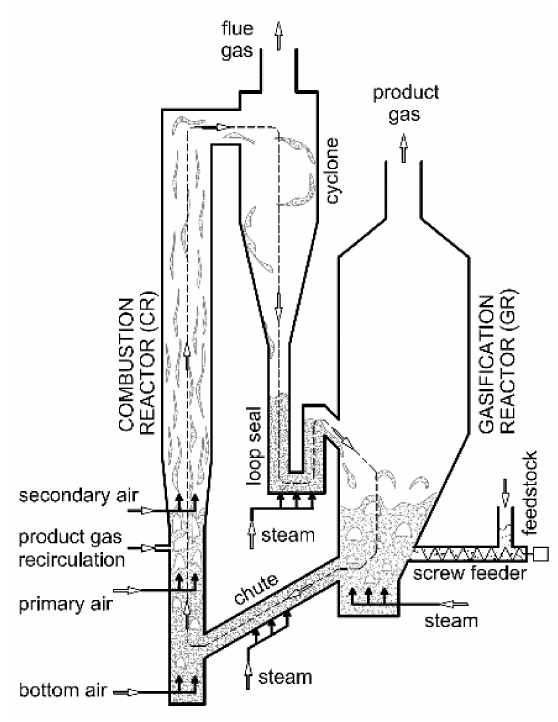
Figure 2. The DFB steam gasifier components